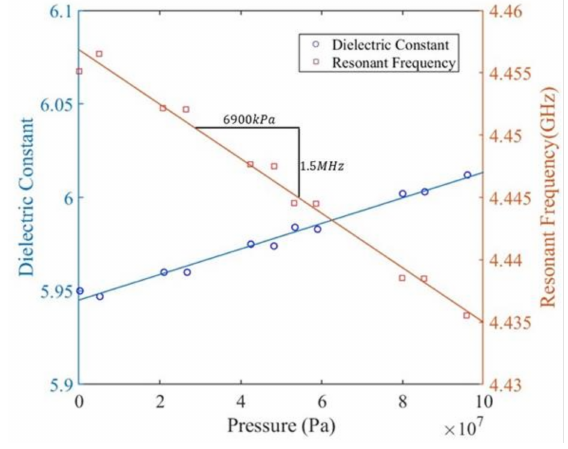
Figure 20. Ramp up Pressure vs. Frequency of pressure sensor during the